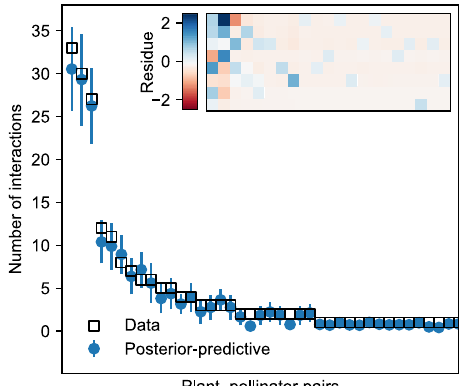
Fig. 2 Results of a posterior – predictive test on the data matrix M for the example data set analyzed in Fig. 1. The main plot shows the error on the 40 largest entries of M , while the inset shows the residue matrix M (cid:2) h ~ M i . Because the actual data M are well within one standard deviation of the posterior – predictive mean, the test con fi rms that the model is a good fi t in this case. Error bars correspond to one standard deviation and are computed with n = 2000 samples from the posterior